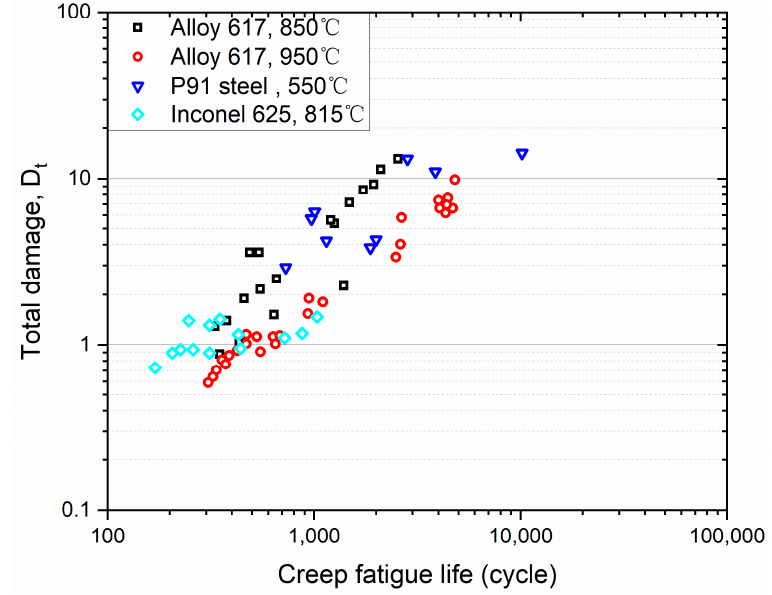
Figure 10. Total damage vs. creep-fatigue